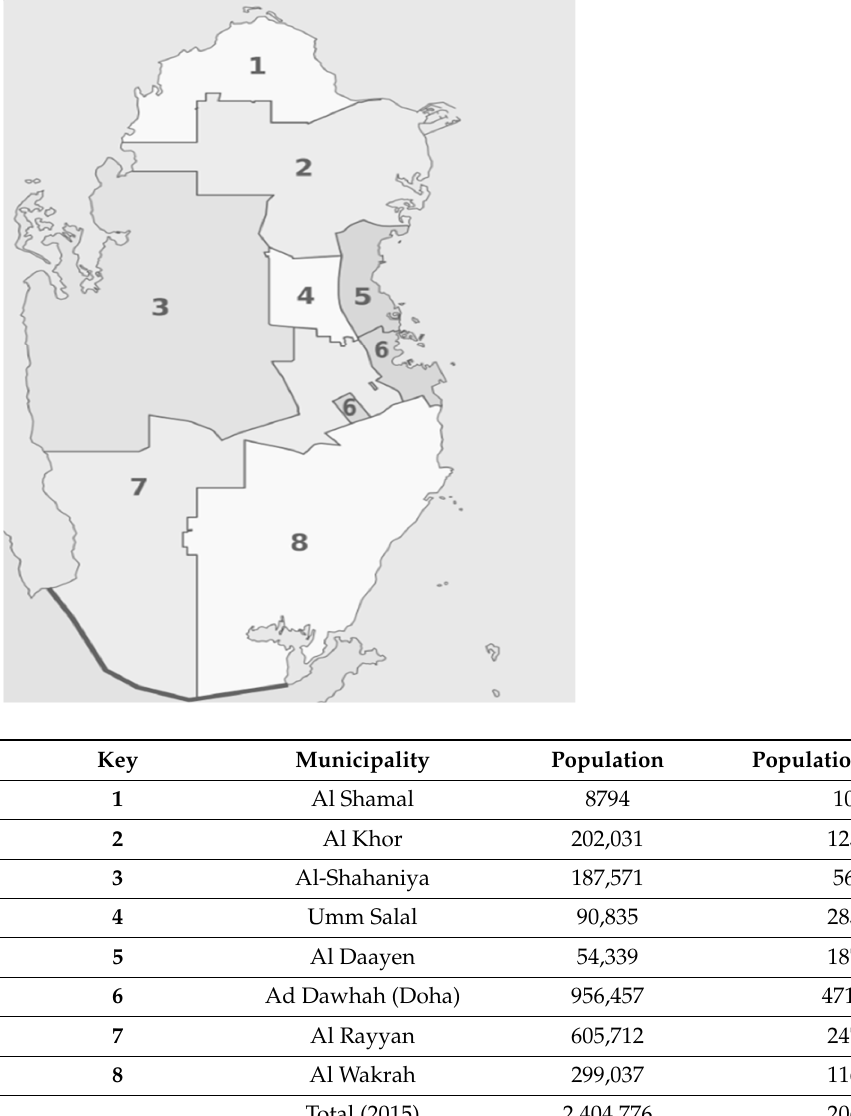
Figure 1. Map of the eight municipalities of Qatar in 2015.